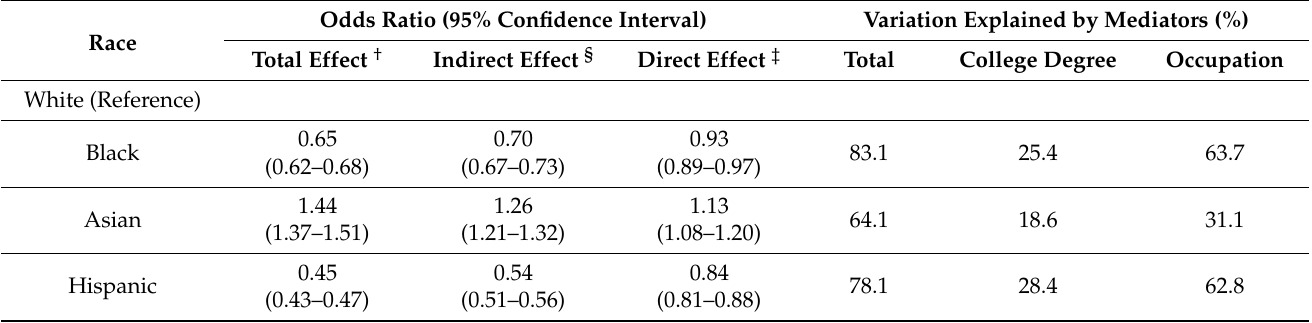
Table 3. Total, direct, and indirect effects of race on teleworking: CPS May 2020 through July